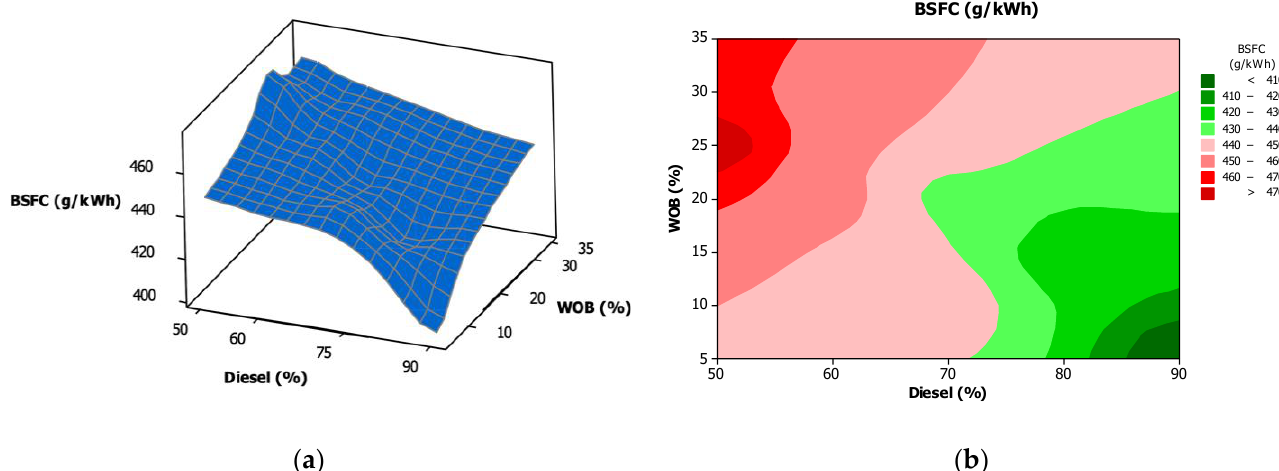
Figure 4. ( a ) Surface plot; ( b ) contour plot of BSFC with input variables. CO emissions as a function of blend ratio of components are shown in Figure